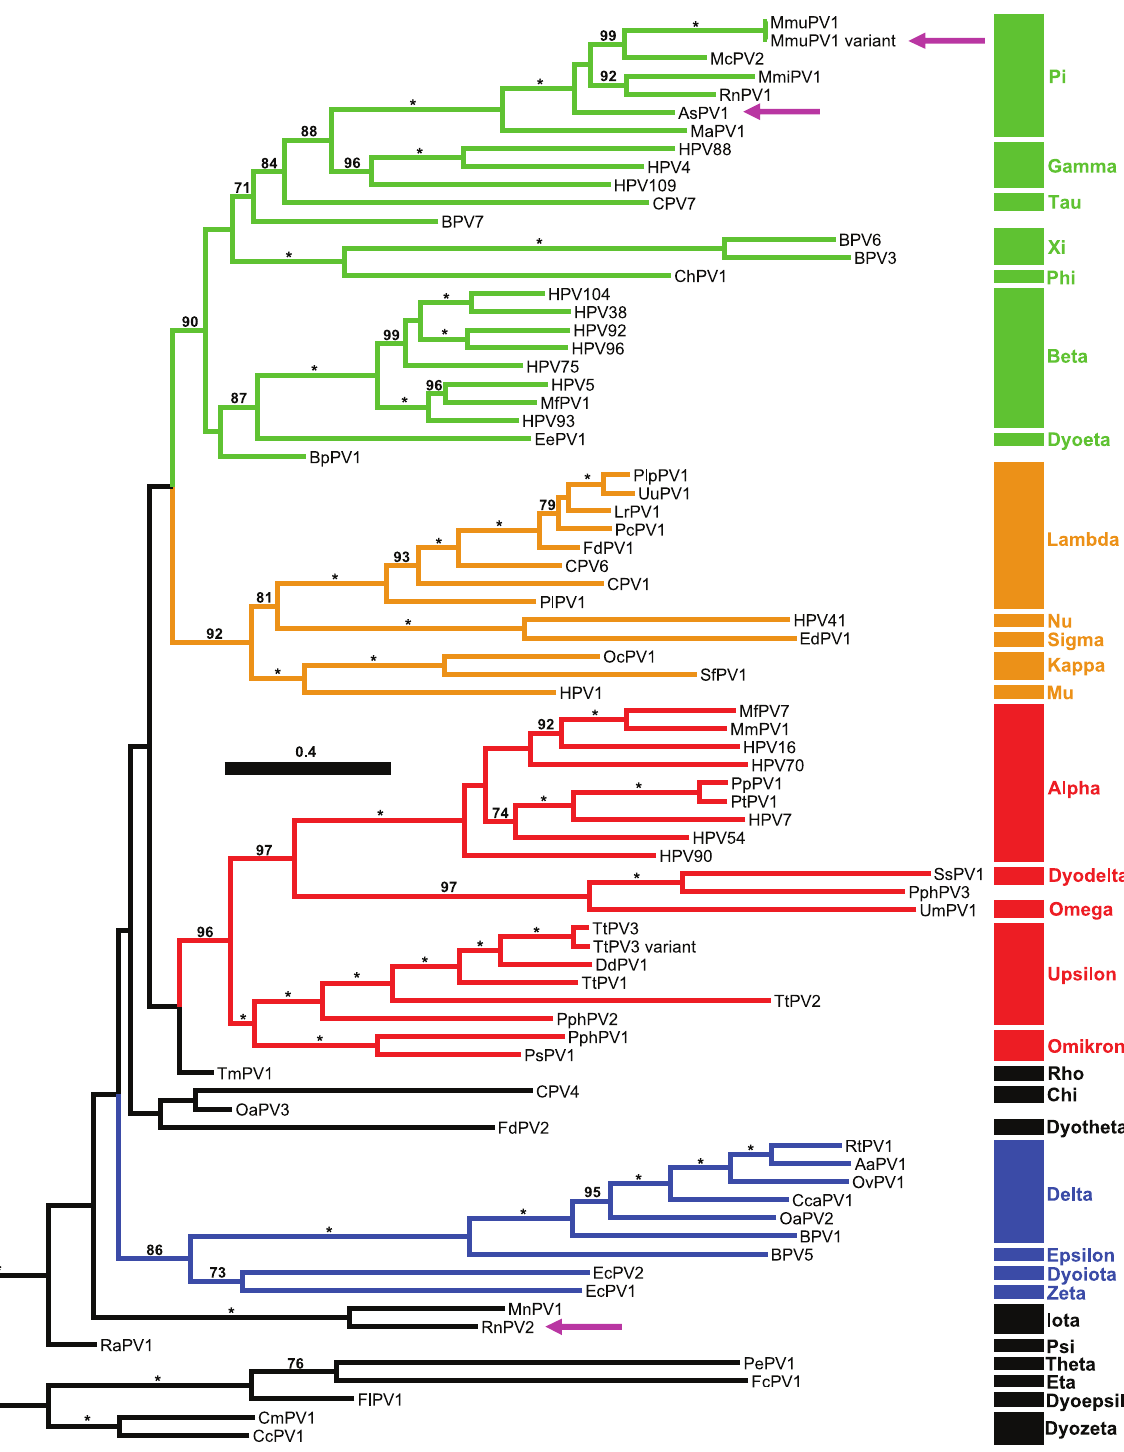
Figure 2. Maximum Likelihood (ML) tree of papillomaviruses (PV). ML tree comprising a representative set of 79 types including our two novel types (AsPV1, RnPV2) and one variant (MmuPV1 variant), as inferred from predicted E6, E7, E1, E2, L2, and L1 aa sequence analysis (3,720 aa positions, of which 69% were parsimony-informative). Generic PV clades [11] are indicated by Greek lettering. Supertaxa are colored red (Alpha + Omikron-PV), green (Beta + Xi-PV), blue (Delta + Zeta-PV), and ocher (Lamda + Mu-PV), respectively. Branch lengths are drawn to scale, with the scale bar indicating the number of nt substitutions per site. Numbers on branches are bootstrap support values under the ML criterion; values under 50 are not shown. The novel PV types and variant of our present study are highlighted by arrows. According to the common PV-nomenclature our novel variant of Mus musculus is referred to MmuPV1 variant.